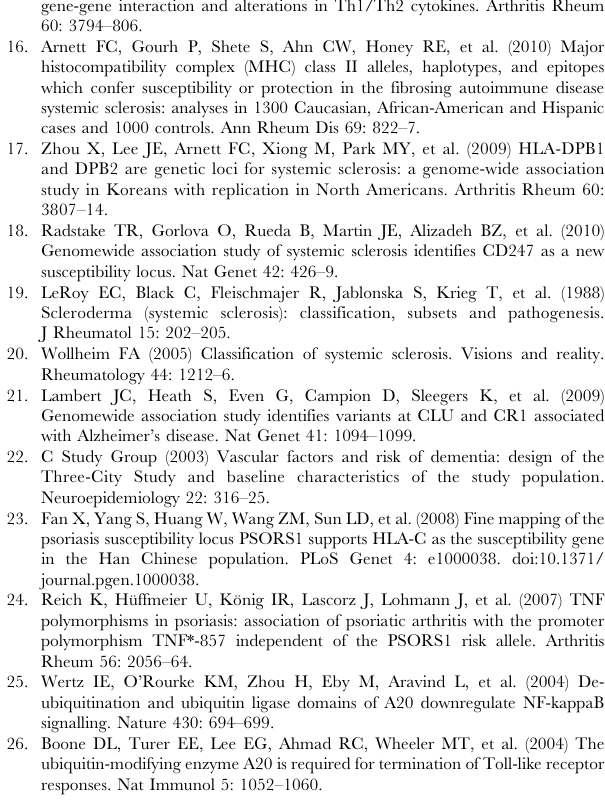
Table S1 GWAS results for the most associated (P , 10 2 4 ) SNPs. Table S2 Results of conditional logistic regression analysis for 28 SNPs (P , 10 2 3 ) in the MHC region. Table S3 Results of Conditional logistic regression analysis for top 7 SNPs outside the MHC region in GWAS data. Table S4 Association results in the combined (stage-1 and stage- 2) data for the replicated SNPs by sub-type of SSc patients.